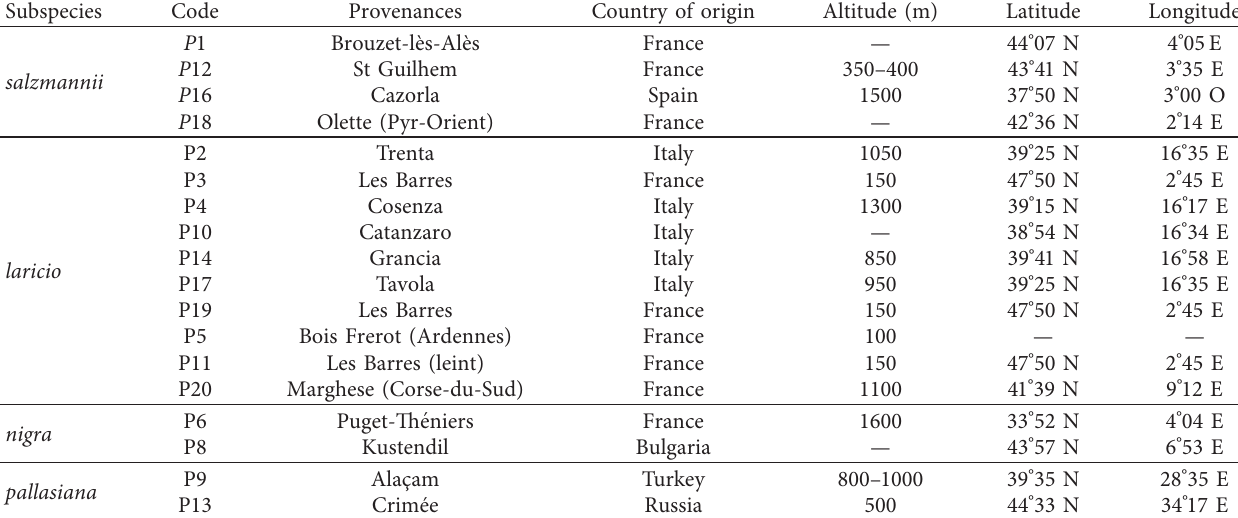
Table 1: Geographic origin of the eighteen provenances of Pinus nigra Arn.